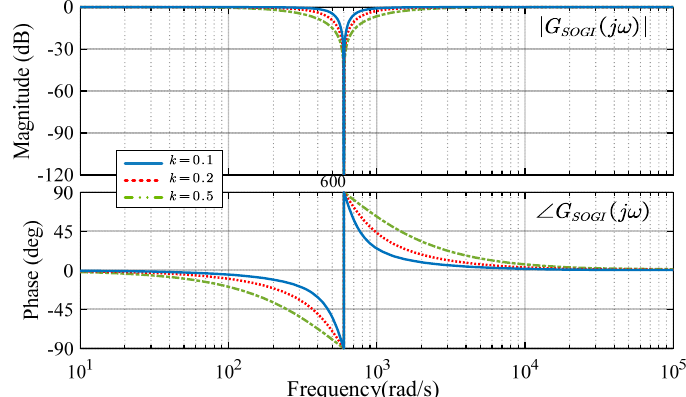
ω = rad/s). Figure 5. Bode diagram of the G SOGI ( s ) ( ω re = 600 rad/s).